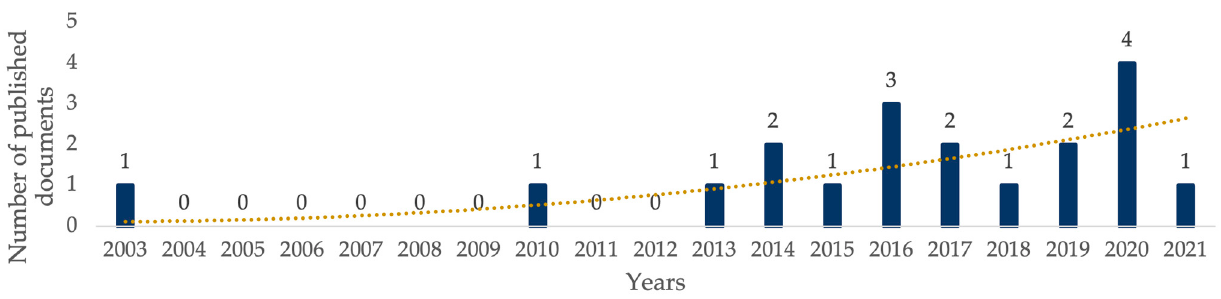
Figure 3. Evolution of published documents related to hypoxia in strength and hypertrophy variables in recent years.